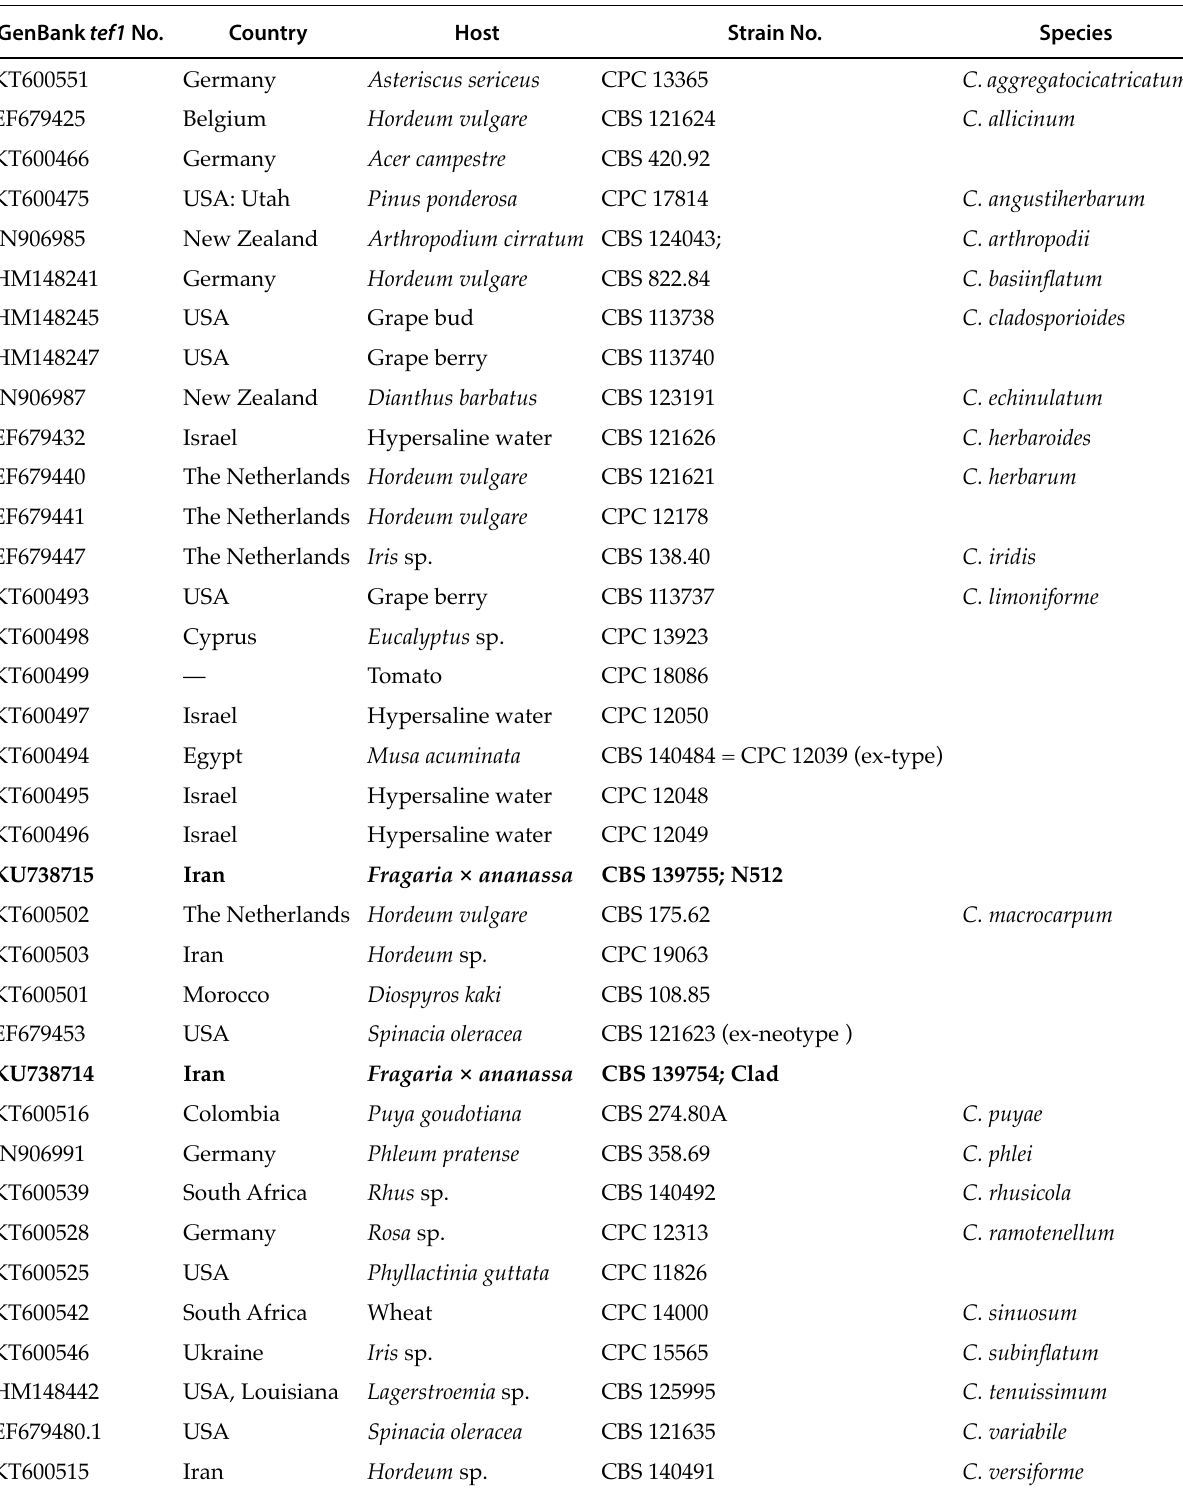
Table 1. List of isolates used to infer the phylogenetic tree. The isolates used in this study are shown in bold. GenBank tef1